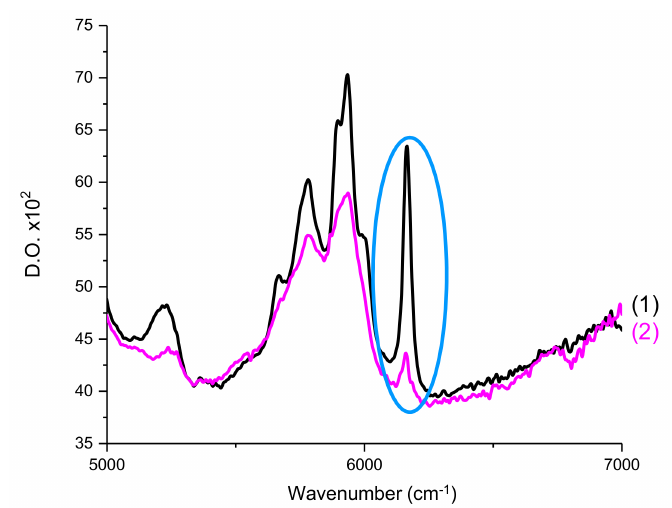
Figure 12. RT-FTIR spectra of Mix-MA between 5000–7000 cm − 1 (1) before polymerization and (2) after polymerization. Circled in blue is the peak used to calculate the double bond C = C conversions of the